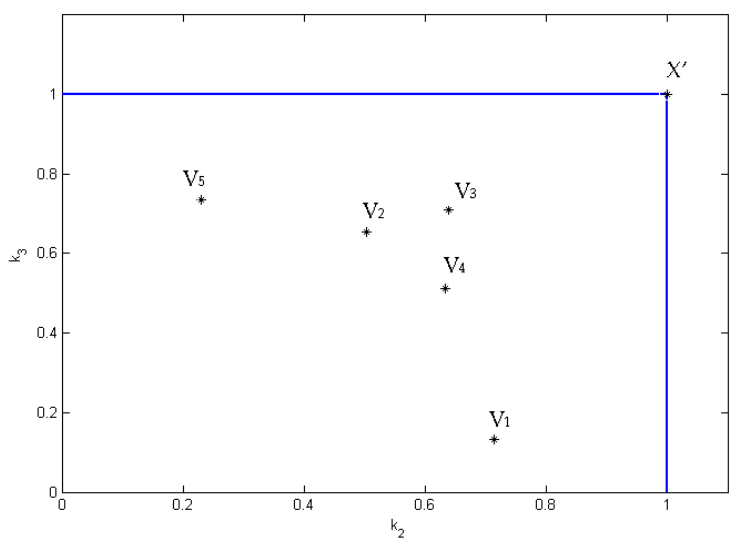
Figure 9. Graphical interpretation of target point X’ in the compromise programming method: k1 and k2—decision criteria; V1, V2, V3, V4, and V5—100% of electrical energy intended to power the